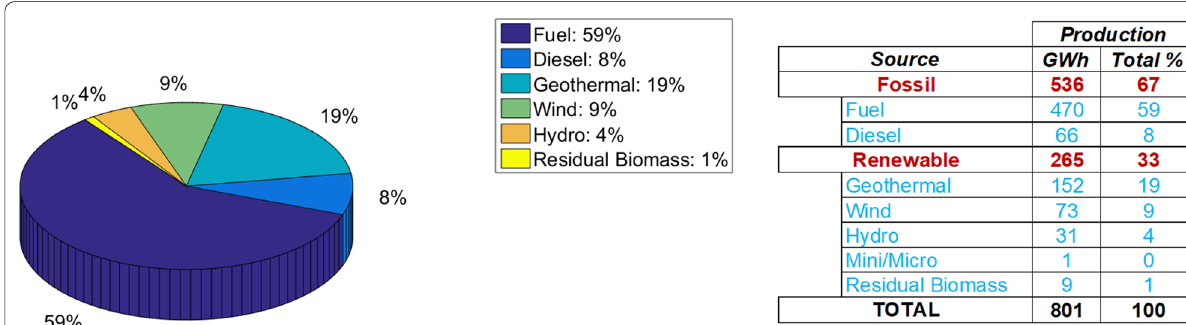
Fig. 2 Produced energy in Azores archipelago (sourced and adapted from Stenzel et al. (2017))